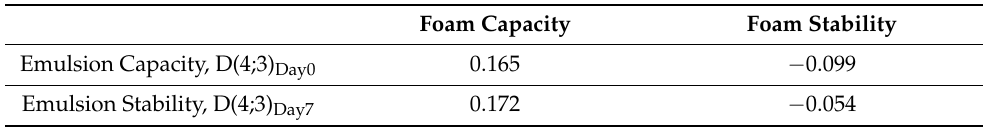
Table 2. Pearson’s correlation analysis between foaming and